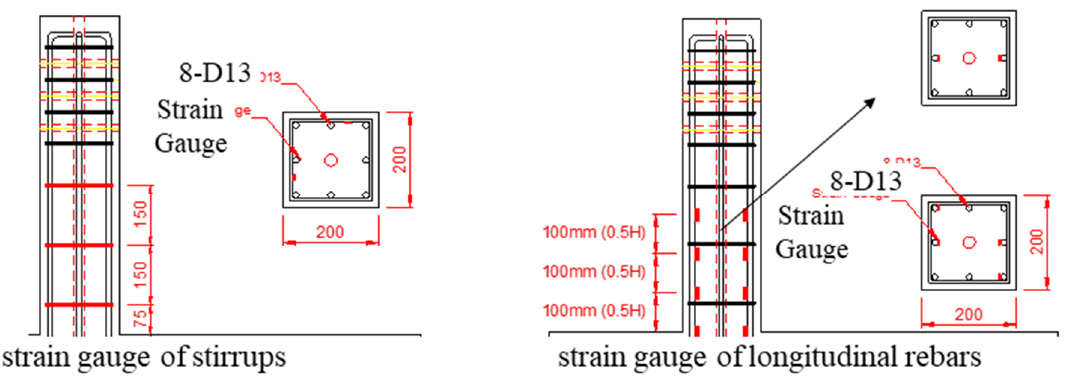
Figure 7. Strain gauges.